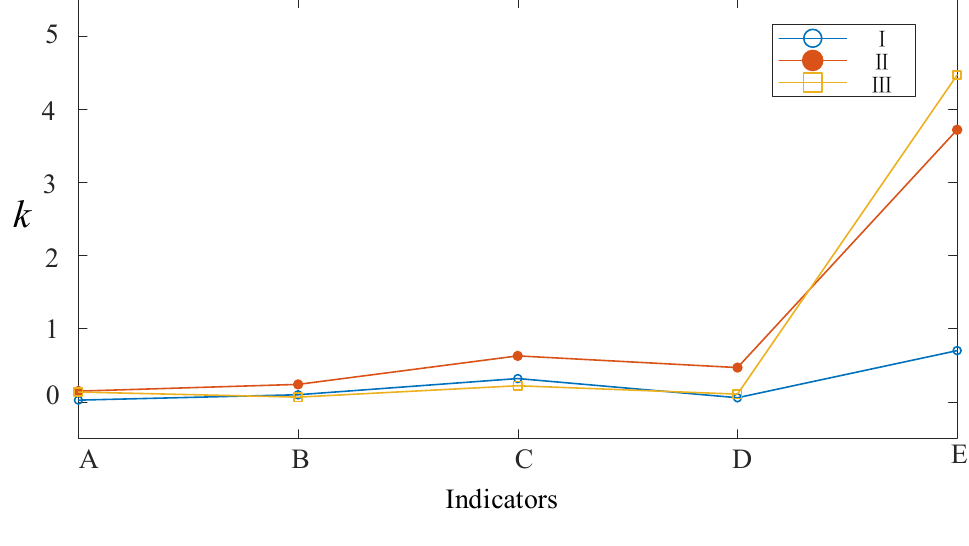
Figure 17. IGR of each index. Table 4. IGR of each indicator.